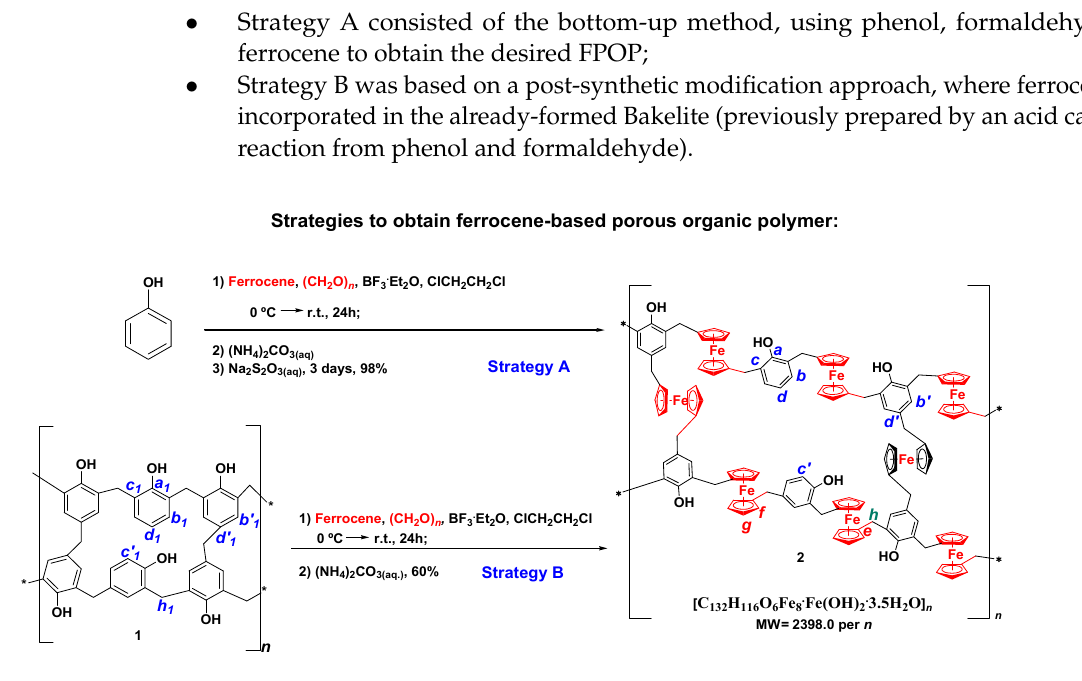
Figure 2. Synthesis of ferrocene-based porous organic polymers (FPOPs), using as starting materials phenol (Strategy A) and Bakelite (Strategy B). The core Bakelite skeleton is represented in black, in which carbon atoms and groups related to FPOP are highlighted in blue, whereas the inserted 1,1 ′ - ferroenenomethylene unit is in red and the indistinguishable methylene in green.